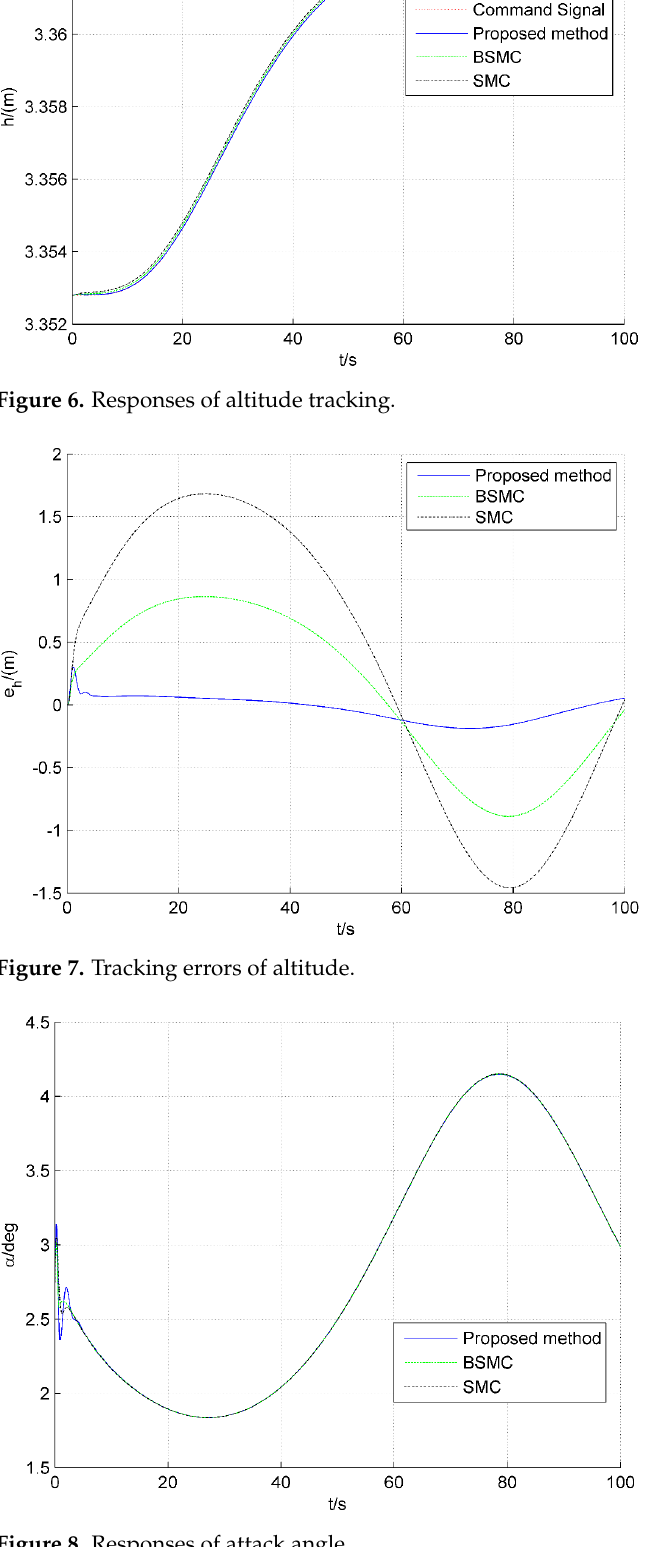
Figure 8. Responses of attack angle.